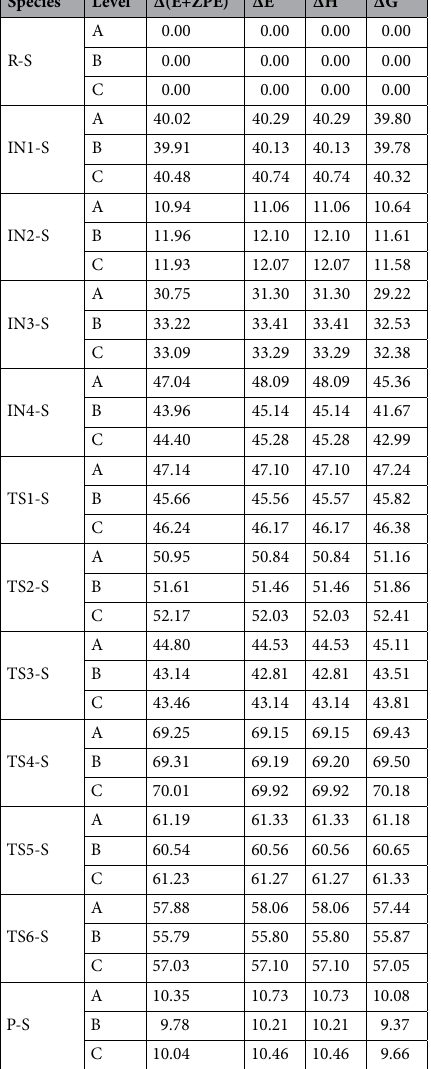
Table 7. Relative energies corrected by ZPE, thermal energies (ΔE°), enthalpy energies (ΔHº), and Gibbs free energies calculated for all stationary points of 3-hydroxythiophen-2(5H)-one unimolecular reaction at different levels. A, B, and C are CBS-QB3, M06-2X/Jun-cc-pV(T+d)Z, and M06-2X/6-311+g(2df,2p) levels,